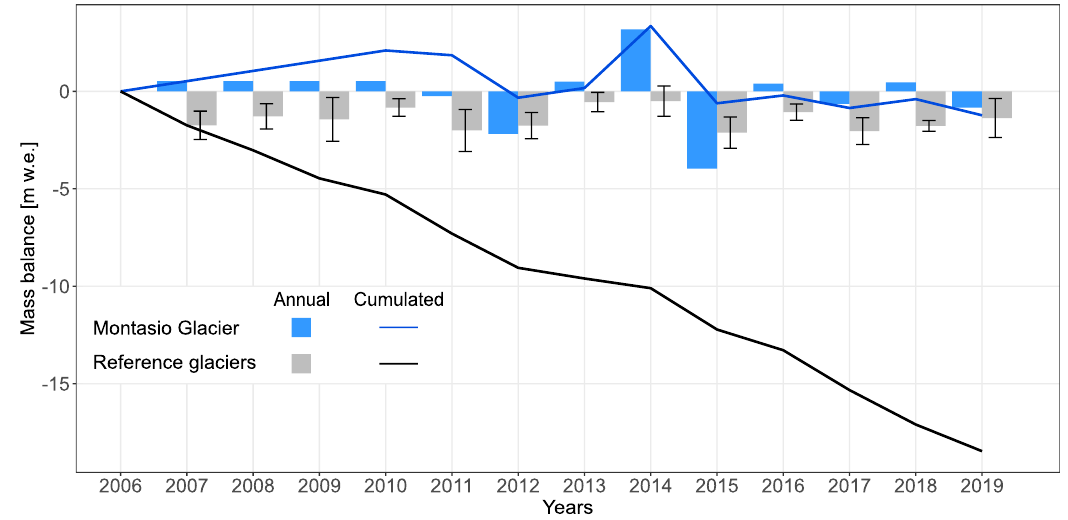
Figure 4. Annual and cumulated geodetic mass balance on the Montasio Glacier compared with the average glaciological annual and cumulated balance of nine reference glaciers in the European Alps, in the period from 2006 to 2019.